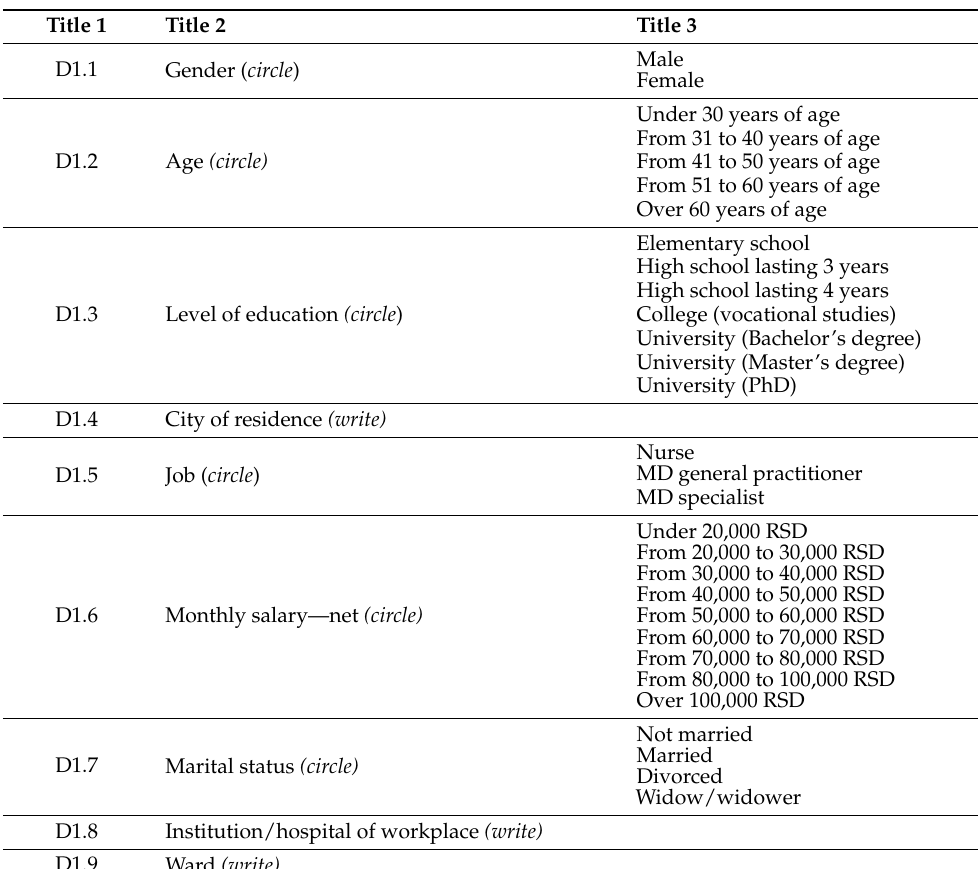
Table A1. Sociodemographic characteristics of